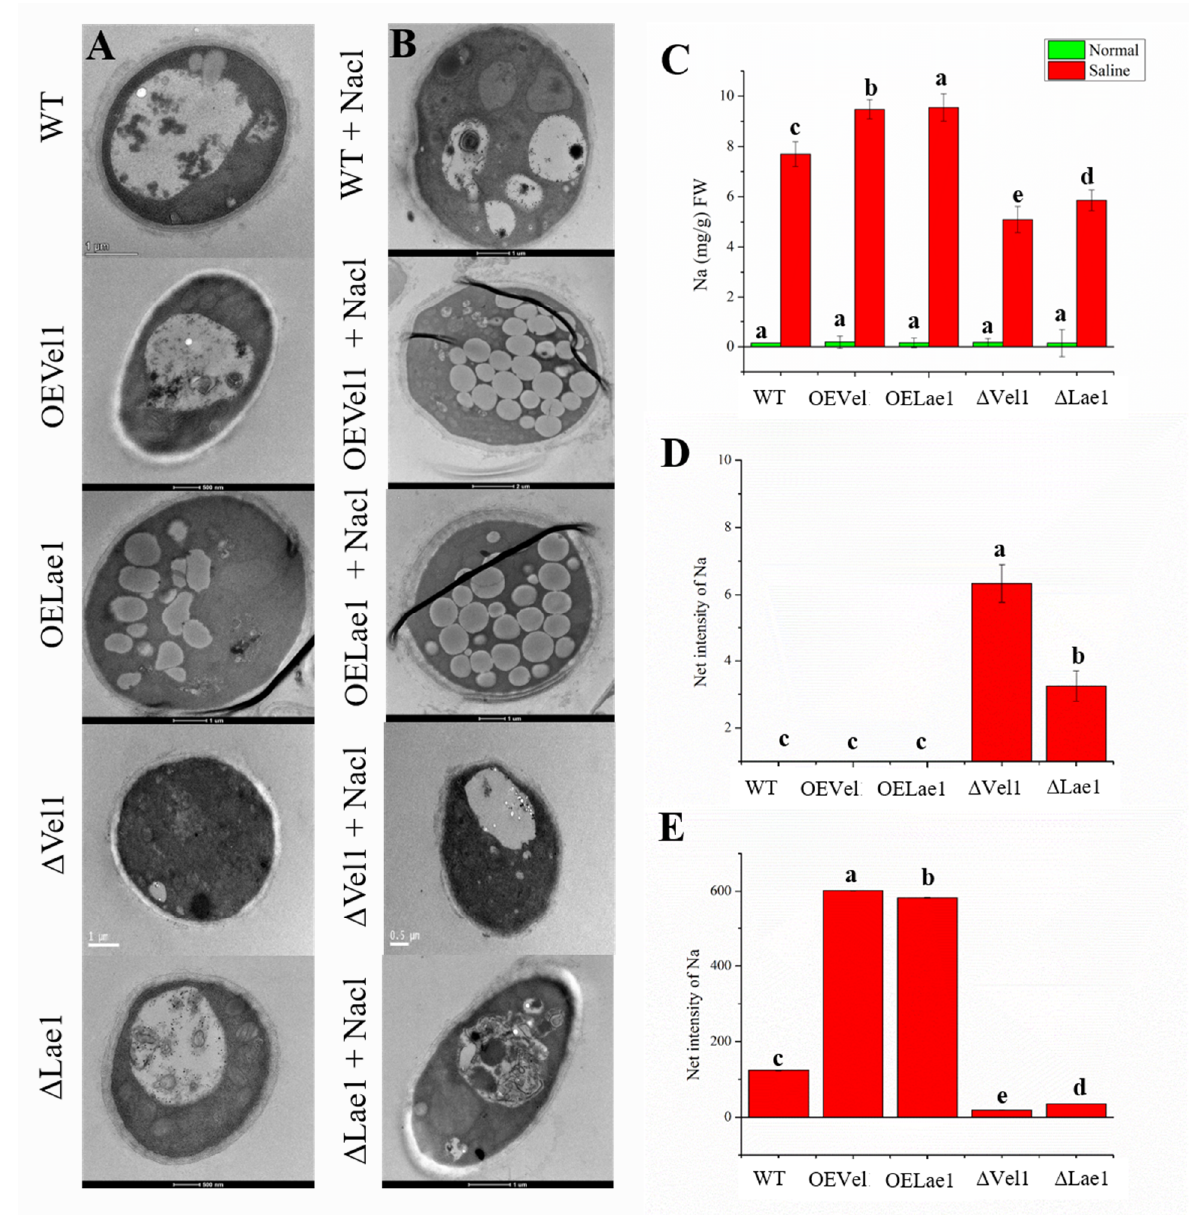
Figure 4. Osmo-adaptation of T. asperellum WT, OE Vel1 , OE Lae1 , Δ Vel1 , and Δ Lae1 under osmotic stress. ( A ) Transmission electron microscopic images of T. asperellum WT, OE Vel1 , OE Lae1 , Δ vel1 , and Δ lae1 under normal growth condition. ( B ) Changes in the cell wall thickness and number of vacuoles for T. asperellum WT, OE Vel1 , OE Lae1 , Δ Vel1 , and Δ Lae1 after exposure to hypo-osmotic stress. ( C ) Na + absorption of T. asperellum WT, OE Vel1 , OE Lae1 , Δ Vel1 , and Δ Lae1 under normal and saline stress conditions. ( D ) Localization of Na + in the vacuoles of T. asperellum WT, OE Vel1 , OE Lae1 , Δ Vel1 , and Δ Lae1 under saline stress conditions. ( E ) Localization of Na + in the cell wall membrane of T. asperellum WT, OE Vel1 , OE Lae1 , Δ Vel1 , and Δ Lae1 under saline stress conditions. Values are the average of biological triplicates. Error bars represent the standard error. Bars with different letters represent a statistically significant difference from each other at the level of p < 0.05 based on the ANOVA.